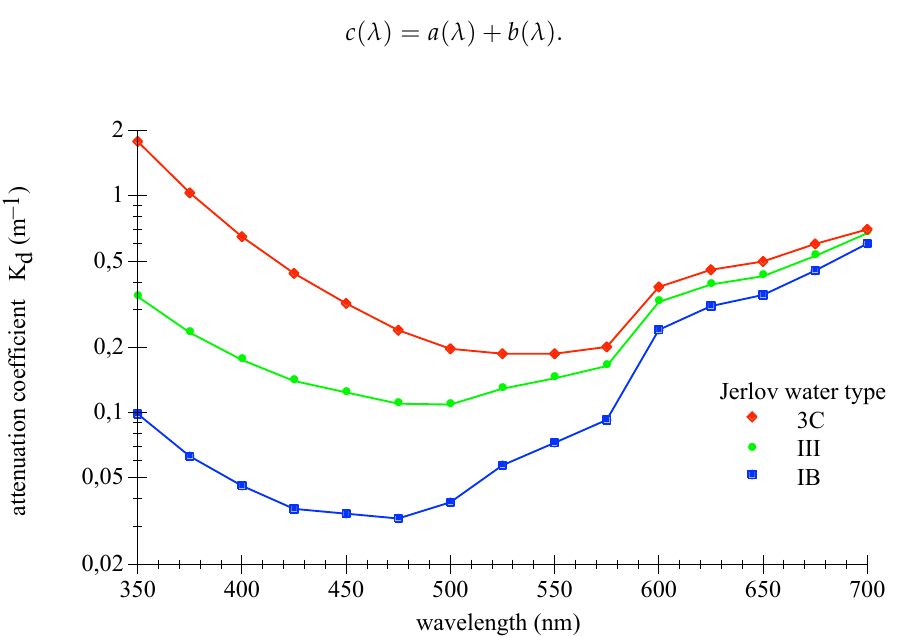
Figure 1. Spectral diffuse attenuation coefficients, K d , of downwelling irradiance for three Jerlov water types, replotted from database